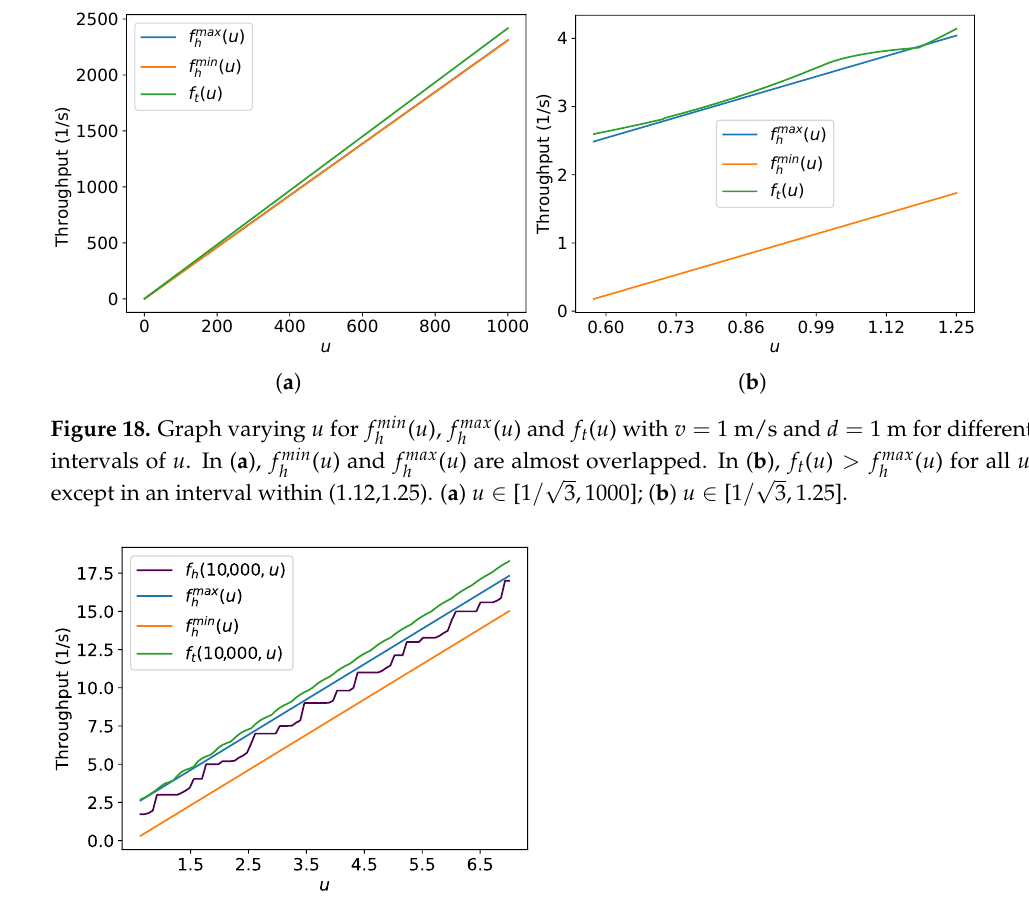
Figure 19. Example for T = 10,000 s, v = 1 m/s, d = 1 m and 100 equally spaced points of √ u ∈ [1 / 3,7]. f h ( T , u ) < f t ( T , u ), albeit f max